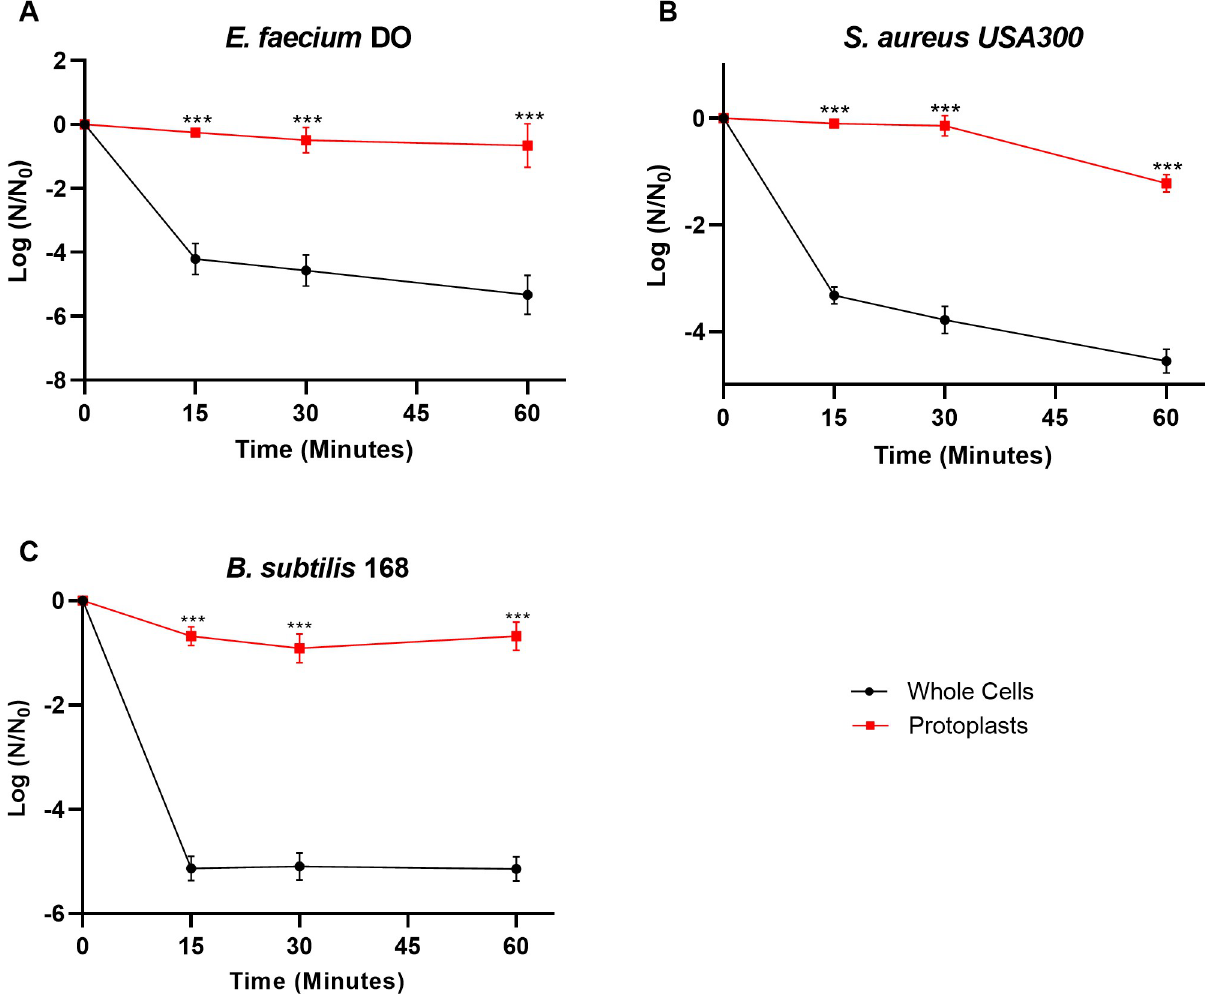
Fig 6. Removal of peptidoglycan increases tolerance to daptomycin in E . faecium , S . aureus , and B . subtilis . (A) Treatment of either E . faecium whole cells or protoplasts (see Materials and Methods) with 30 μ g/mL daptomycin. Shown are the average log ratios of survivors ± standard deviations for n = 3 replicates. ��� P � 0.001; exact P -values are found in S4 Table. (B) S . aureus whole cells or protoplasts (see Materials and Methods) treated with 5 μ /mL daptomycin. Shown are the average log ratios of survivors ± standard deviations for n = 3 replicates. ��� P � 0.001; exact P -values are found in S4 Table. (C) B . subtilis whole cells or protoplasts (see Materials or Methods) treated with 5 μ /mL daptomycin. Shown are the average log ratios of survivors ± standard deviations for n = 3 replicates. ��� P � 0.001; exact P -values are found in S4